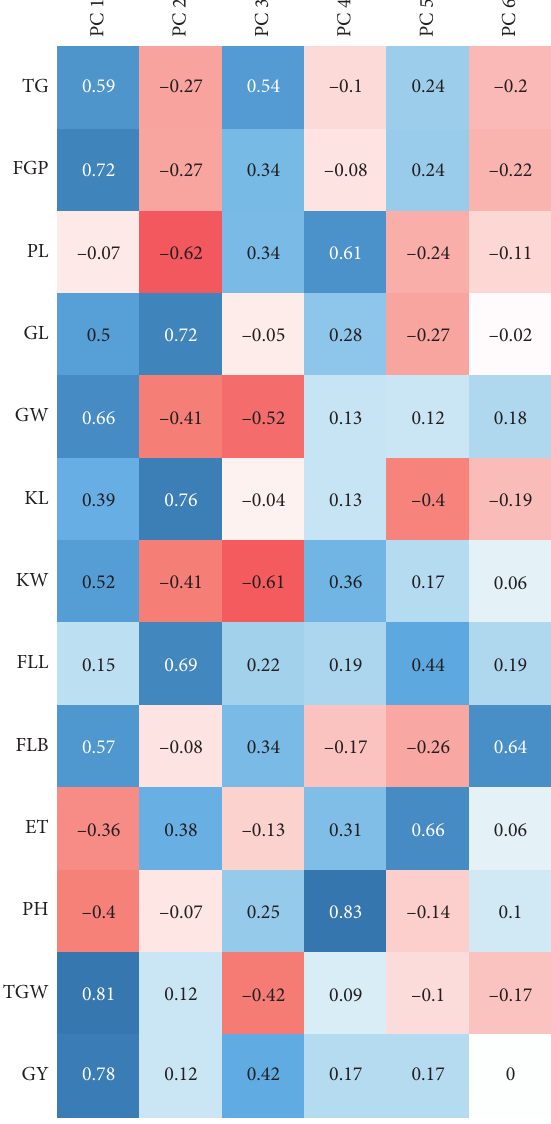
Figure 3: Principal component analysis and its component value for 13 qualitative traits of 30 landraces. The blue colour indicates the positive contribution, and red indicates the negative contri- bution (TG: total grain, FGP: filled grain percentage, PL: panicle length, GL: grain length, GW: grain width, KL: kernel length, KW: kernel width, FLL: flag leaf length, FLB: flag leaf breadth, ET: ef- fective tiller, PH: plant height, TGW: thousand-grain weight, and GY: grain yield).